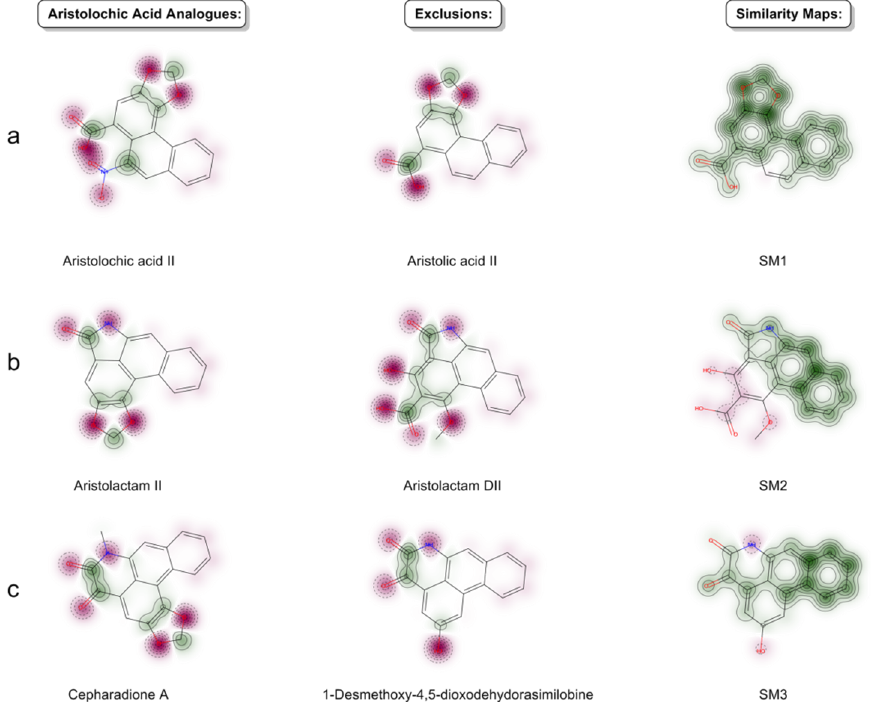
Figure 10. Analysis of Gasteiger partial charges and similarity maps between aristolochic acid analogues and exclusions. ( a ) An example of aristolochic acids (aristolochic acid II) and exclusive AAAs (aristolic acid II). ( b ) An example of aristolactams (aristolactam II) and exclusive AAAs (aristolactam DII). ( c ) An example of 4,5-dioxoaporphines (cepharadione A) and exclusive AAAs (1-desmethoxy-4,5-dioxodehydorasimilobine).